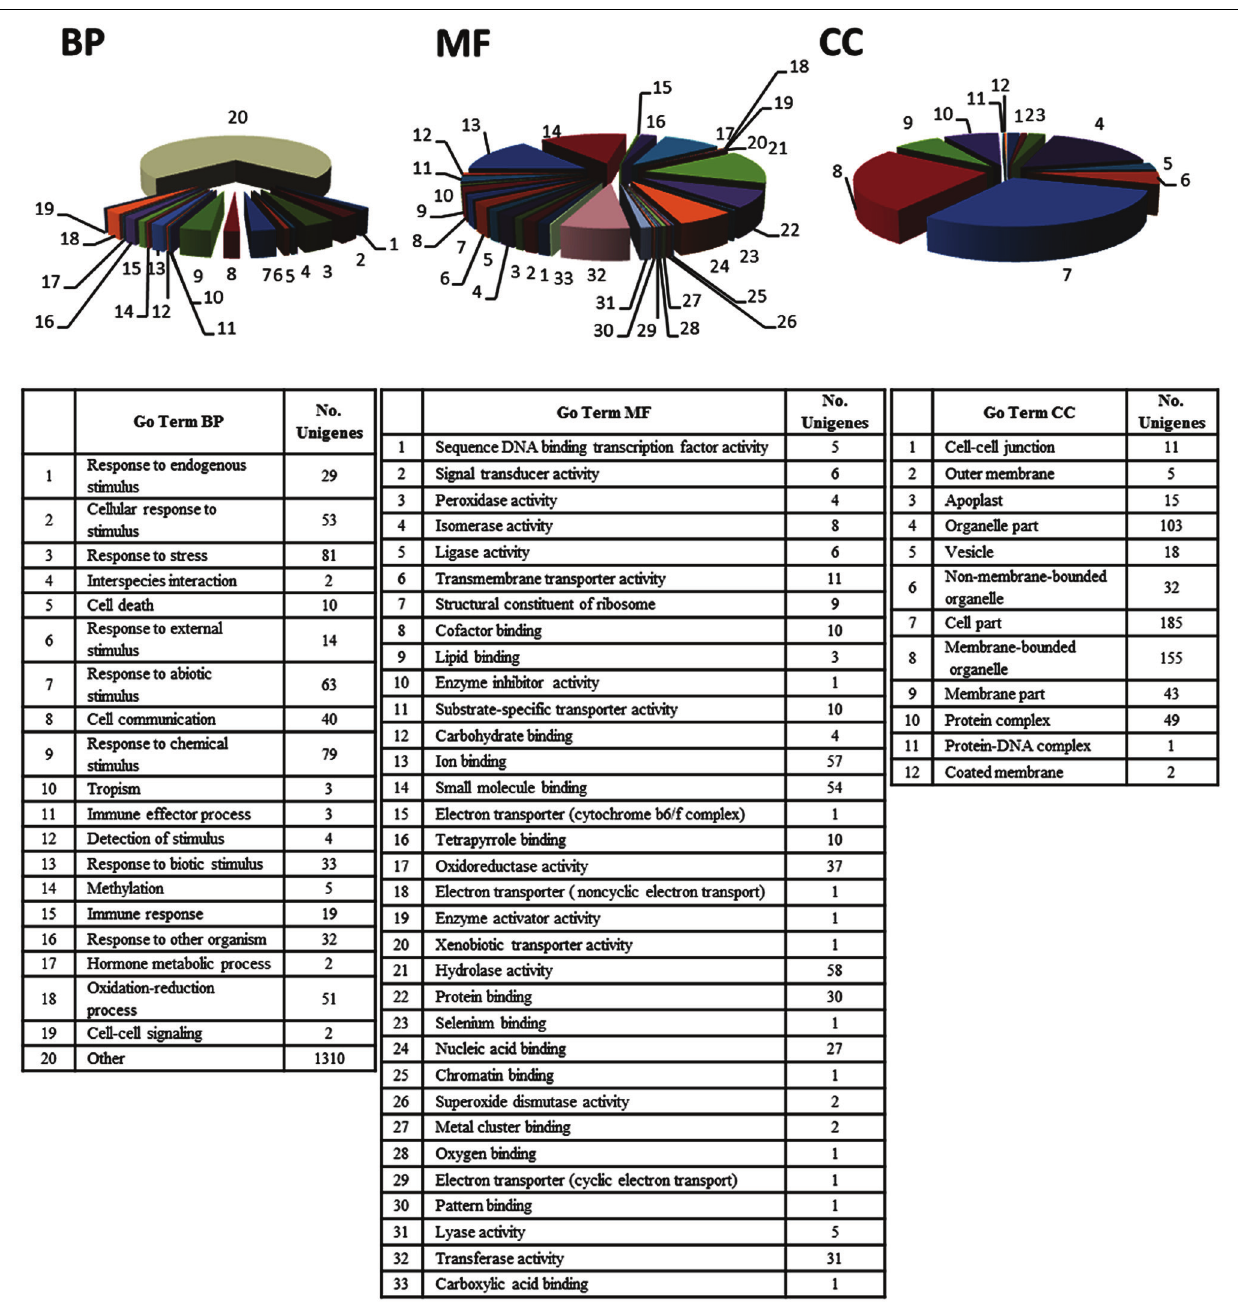
three main GO vocabularies: (BP) “biological processes,” (MF) “molecular functions,” and (CC) “cellular components.” The category “Other” in the main GO vocabulary term “biological processes” clusters 1310 of the transcripts